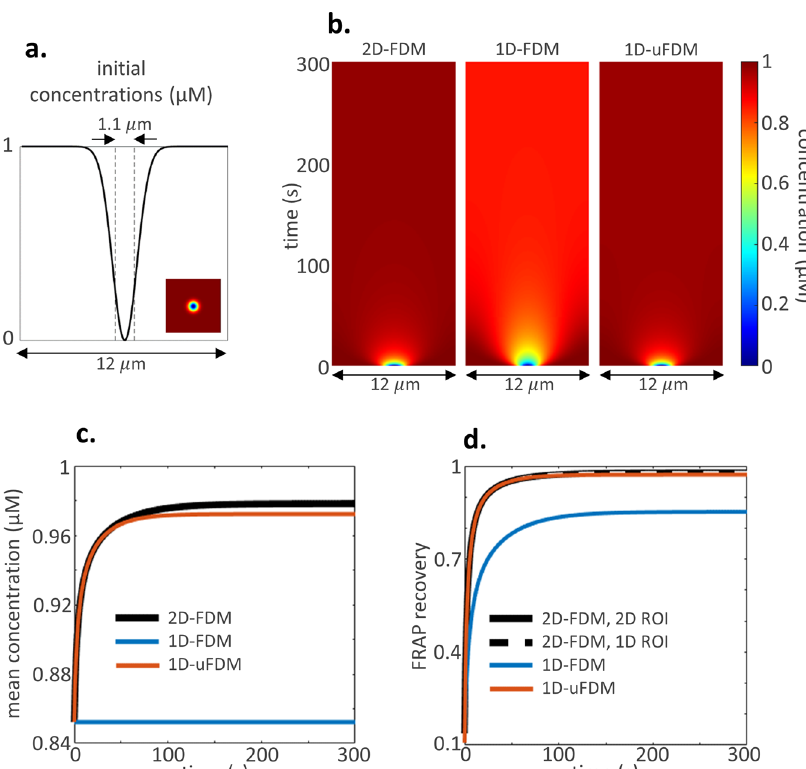
Fig. 3 Illustrative example 2: FRAP initial conditions and results. a Initial concentrations for FRAP simulations after bleaching with a Gaussian laser, radius 0 : 55 μ m 22 . u 1 D x ; 0 ð Þ ¼ 1 (cid:2) e (cid:2) x 2 , inset u 2 D x ; y ; 0 ð Þ ¼ 1 (cid:2) e (cid:2) x 2 þ y 2 ð Þ . Dotted lines show the ROI. b Kymographs of the 2D solution along a slice through the centre of the bleached area, and the 1D solutions. c Mean concentration in the 1D solutions compared with the mean concentration of the 2D solution along a slice through the centre of the bleached area. d FRAP recovery curves. The 2D ROI is a circle diameter 1 : 1 μ m, 1D ROI a line length 1 : 1 μ m.